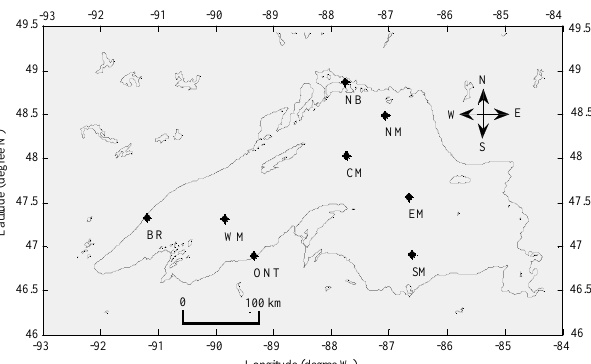
Fig. 1. Map of Lake Superior showing sampling sites across the lake. The open lake sites include western station/mooring (WM), central mooring (CM), northern mooring (NM), eastern mooring (EM), and southern mooring (SM). The nearshore sites are off Bap- tism River (BR), off Ontonagon River (ONT), and off Nipigon Bay